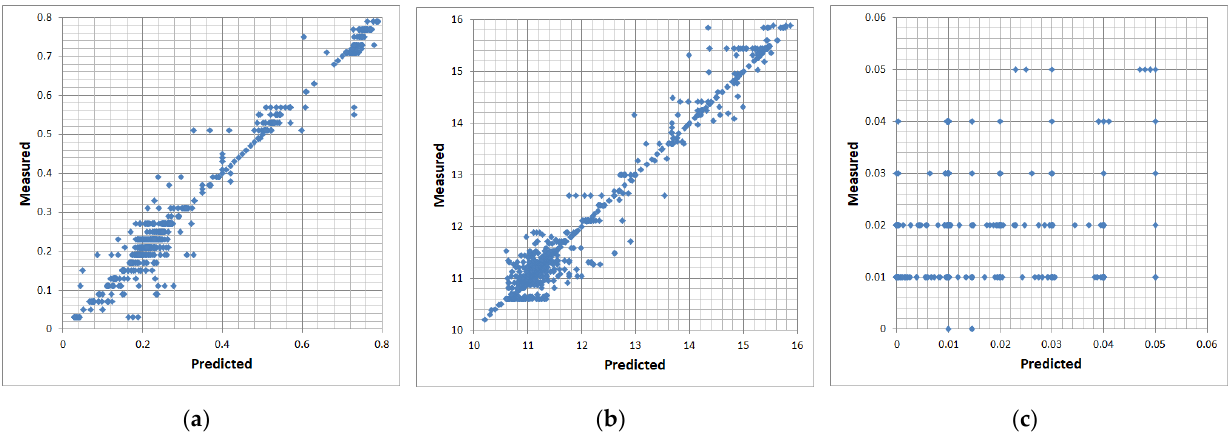
Figure 4. Examples of comparative graphs for ( a ) carbon concentration, ( b ) chromium concentration and ( c ) phosphorus concentration, calculated with use of the artificial neural networks and determined experimentally.